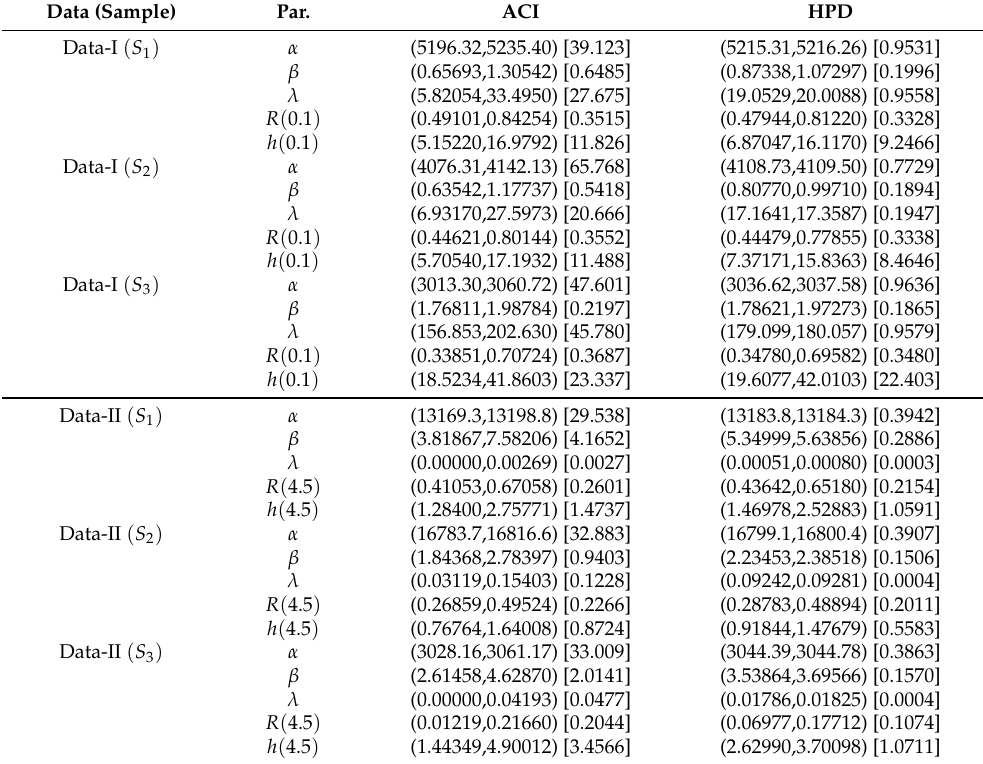
Table 6. Two-sided 95% ACI/HPD credible interval estimates with their [lengths].